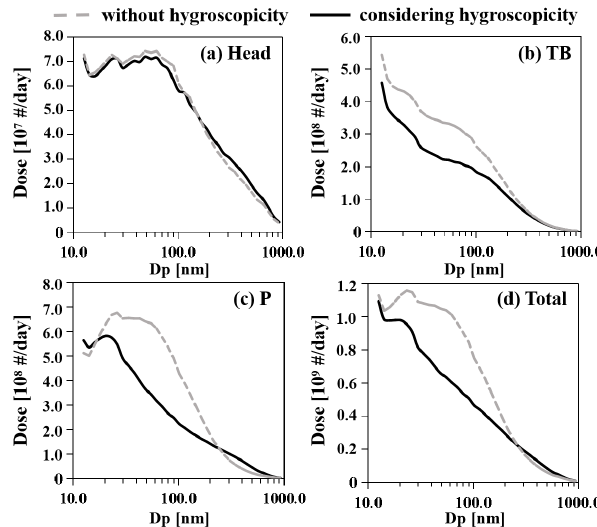
Figure 4. (a) Head, (b) TB, (c) P, and (d) total deposition doses of size-resolved particles for adults with/without considering hy- groscopicity. For clarity, the abscissa of Fig. 4 refers to the dry di- ameter of particles. The gray dashed line represents doses without considering hygroscopicity. The black solid line represents doses considering